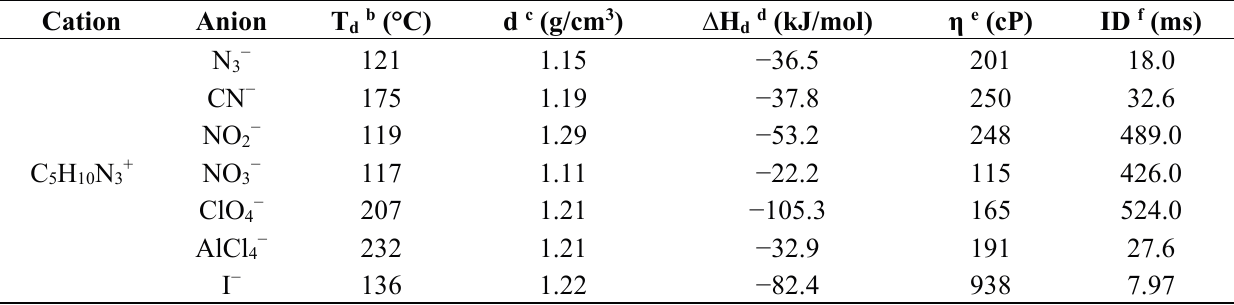
Table 2. Physical and chemical properties of the synthesized 1-ethyl-4-methyl-1,2,4-triazolium salts dissolved at 2-hydroxyethylhydrazine a .